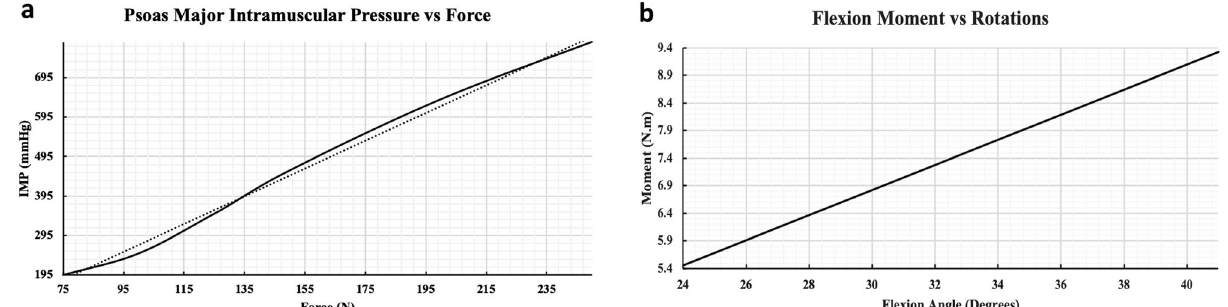
Figure 4. Intramuscular pressure and lumbar spine validation results. ( a ) Results showing the relation between muscle forces (N) and IMP (mmHg) extracted from the psoas major muscle. ( b ) Recorded bending